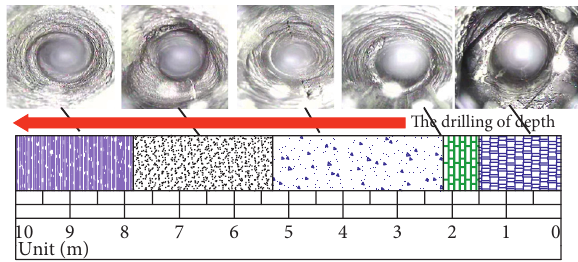
Figure 12: View of roof borehole peeping.